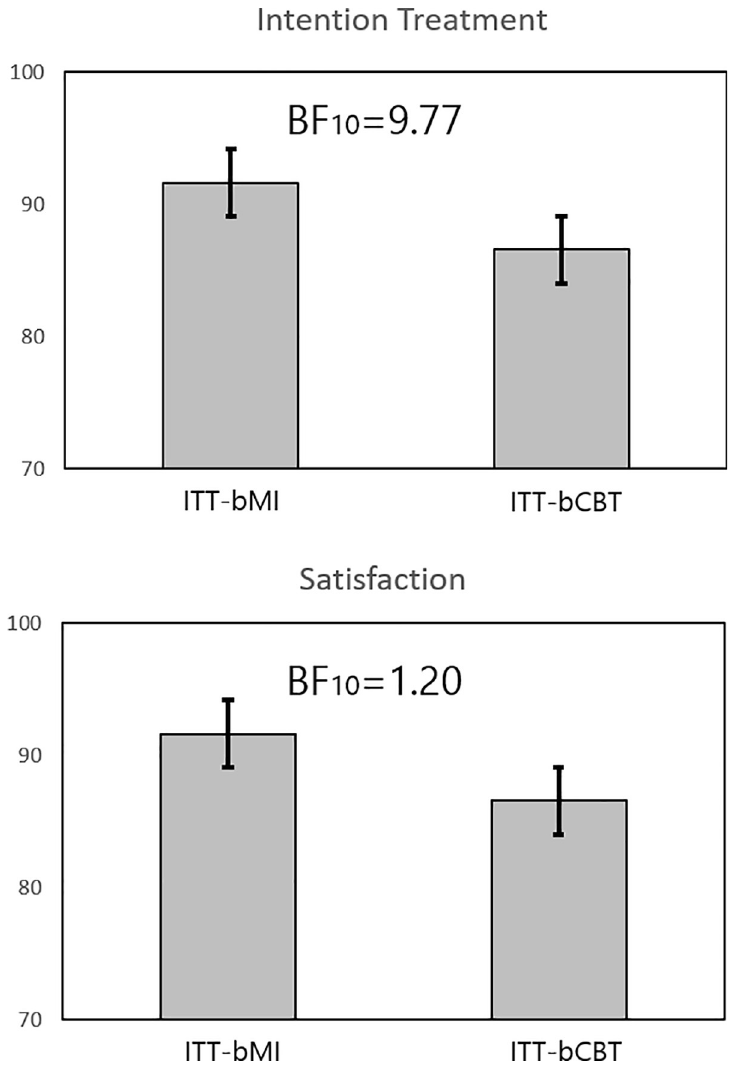
Fig 3. Between-group differences in A) satisfaction with the psychologist and B) Intention to continue treatment. Abbreviations: ITT, Intention-To-Treat; bCBT, brief Cognitive-Behavioral Therapy; bMI, brief Motivational Interviewing; BF 10 , Bayes